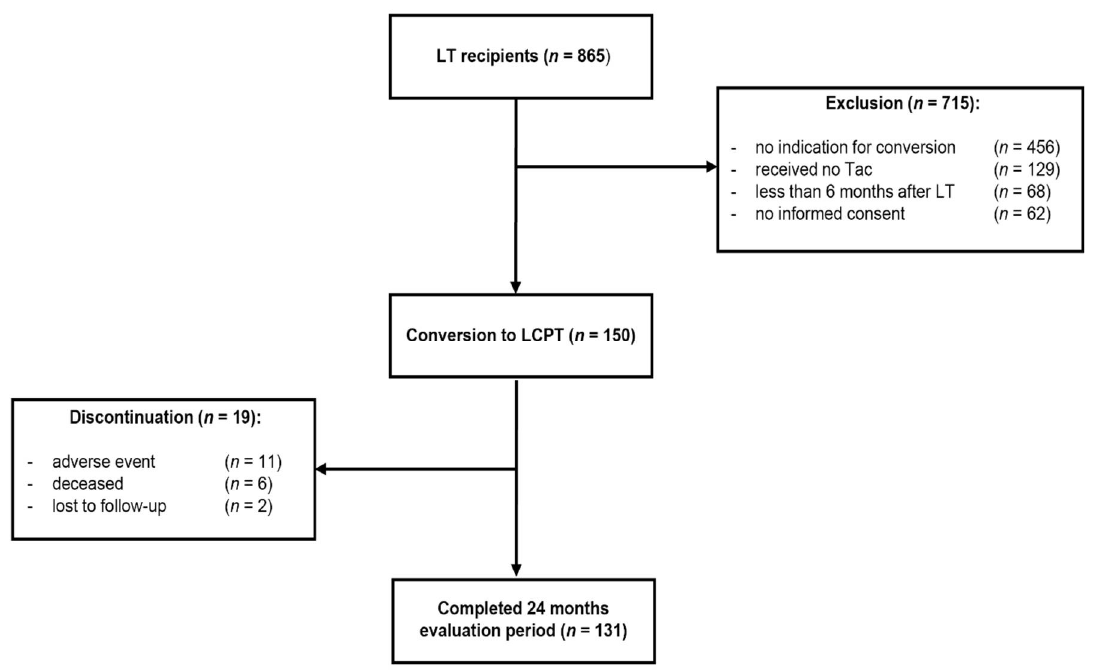
Figure 1. Study design. A total of 865 liver transplant (LT) recipients were screened for eligibility. During the enrolment 150 patients fulfilled the inclusion criteria and were switched to once-daily MeltDose ® tacrolimus (LCPT). Clinical data were analyzed in a 24-month follow-up.